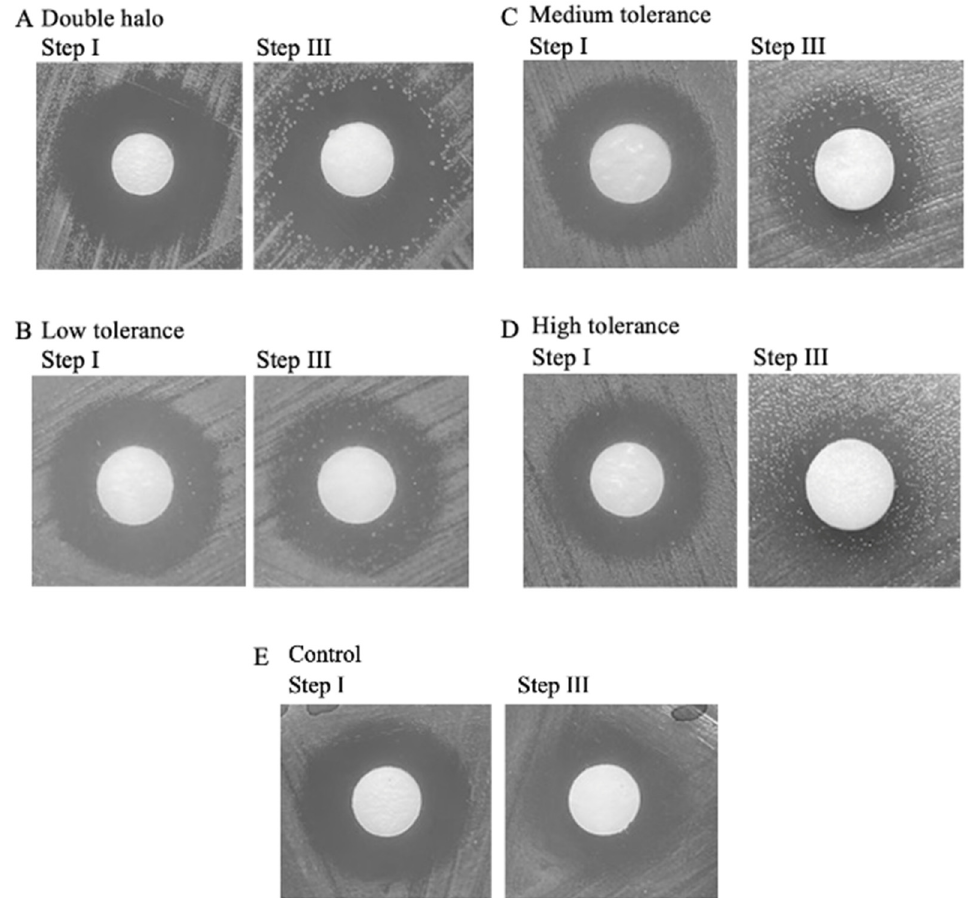
Figure 1. Induced tolerance in WHO P N. gonorrhoeae reference strain cyclically exposed to 3 h 1Ox CRO MIC, detected via a TD test. Step I: after overnight incubation with 0.008 µg CRO discs. Step III: results after nutrient replenishment, ranging from ( A ) a double halo appearance, ( B ) Low tolerance [0–10 colonies], ( C ) Medium tolerance [10–20 colonies], ( D ) High tolerance [>20 colonies], to ( E ) No tolerance; 6 mm discs.